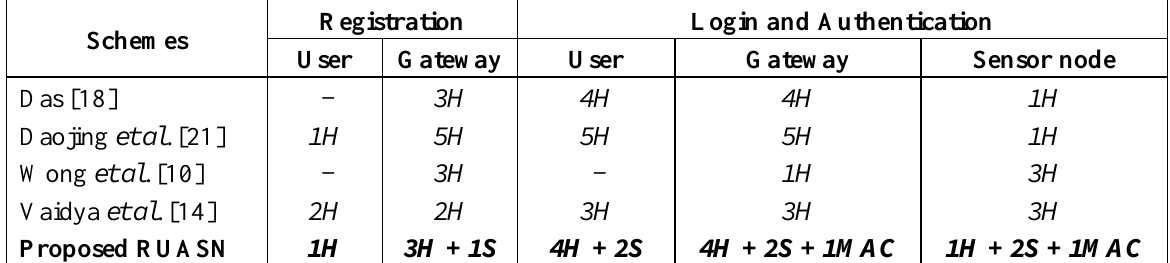
Table 4. A performance comparison of RUASN with the existing